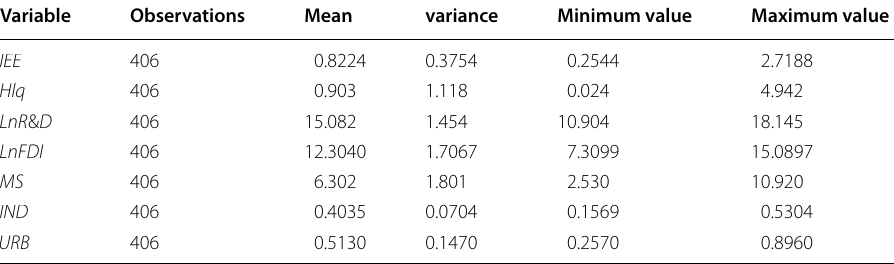
Table 2 Descriptive statistics of each variable